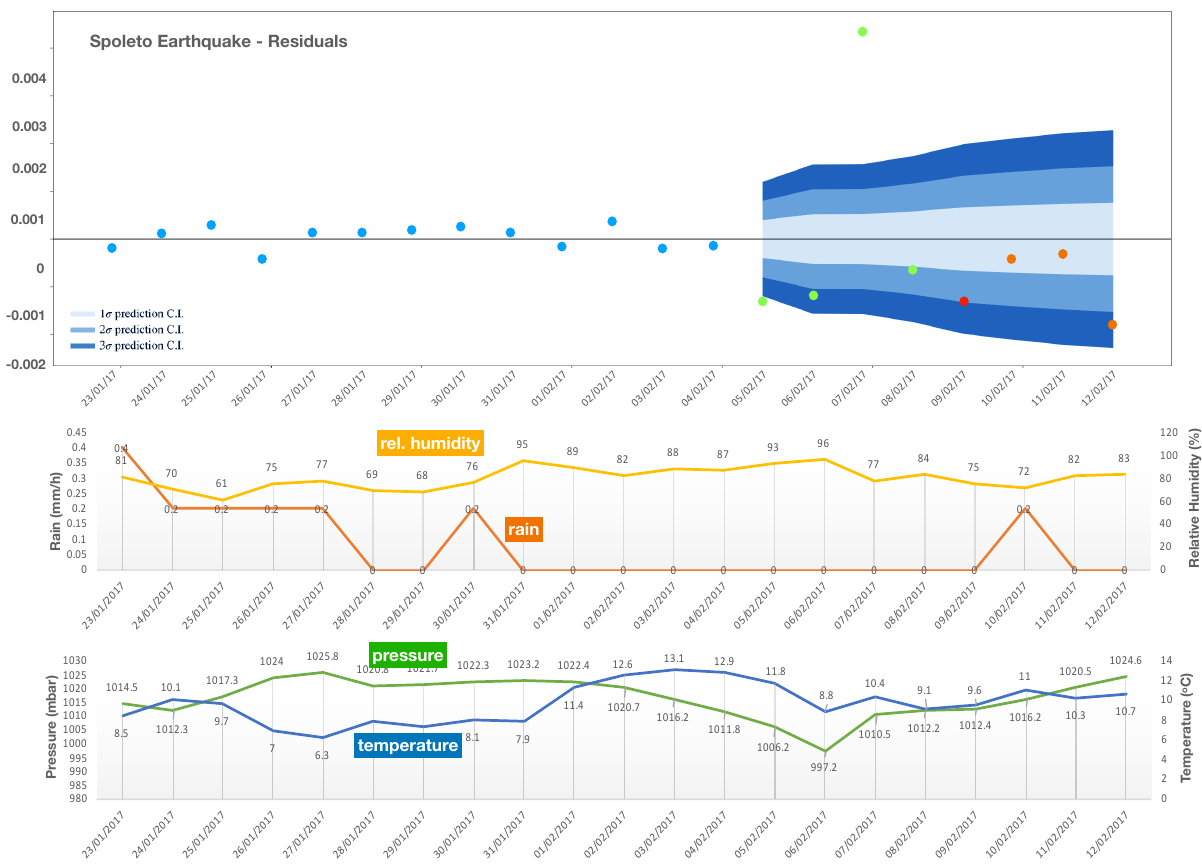
Figure 8. Spoleto earthquake (color on-line)—upper panel: residuals of the best ARFIMA model. Blue points correspond to the dose rate background data and green points to the pre-shock events; the red point is the earthquake event and the orange points represent aftershock events. The confidence level bands for coverage factor k = 1, 2, 3 (from the lightest to the darkest blue) are drawn in the blind time region. In the middle and lower panels the relative humidity, rainfall, temperature, and pressure time series are shown, as indicated by the respective